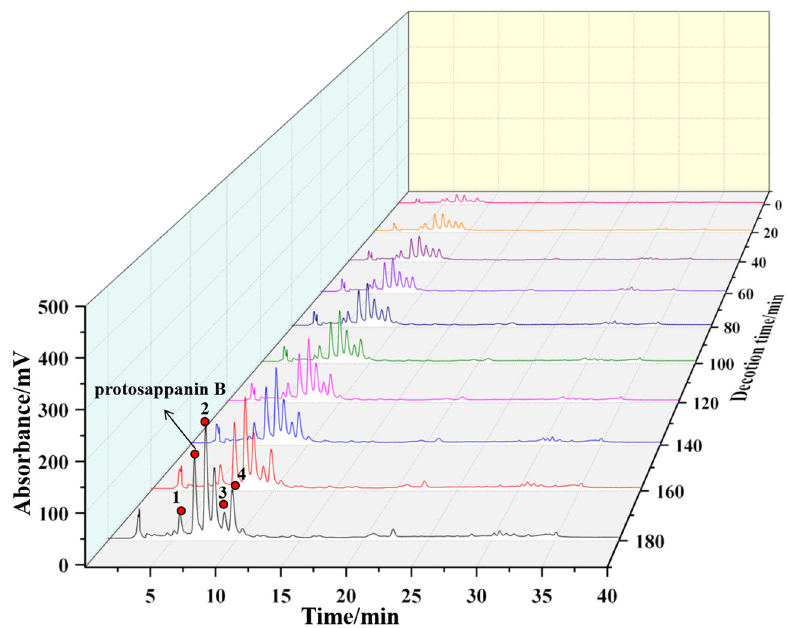
Figure 2: HPLC fi ngerprint of C. sappan L. at di ff erent decoction